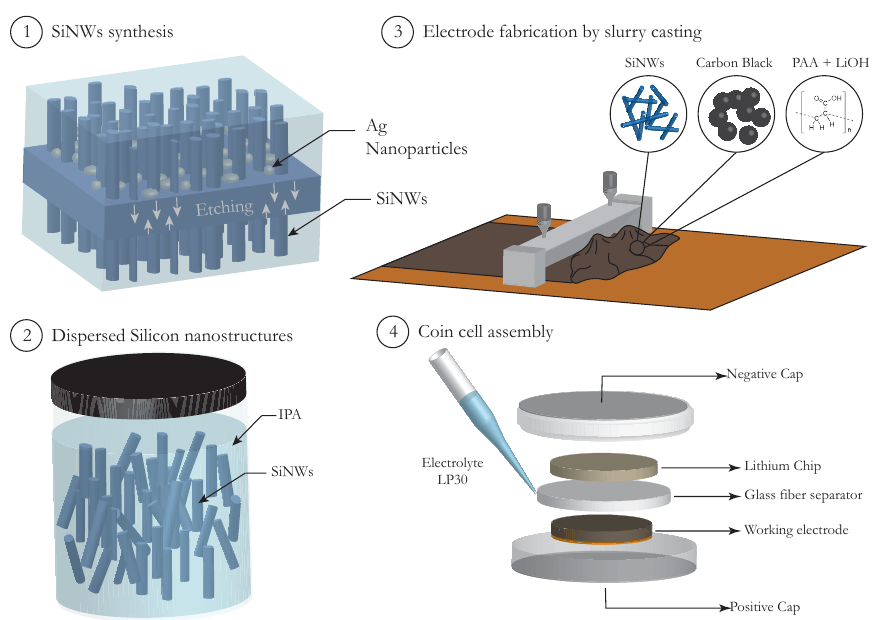
Figure 1. Scheme of the different steps (1–4) for the preparation of batteries with MACE SiNWs